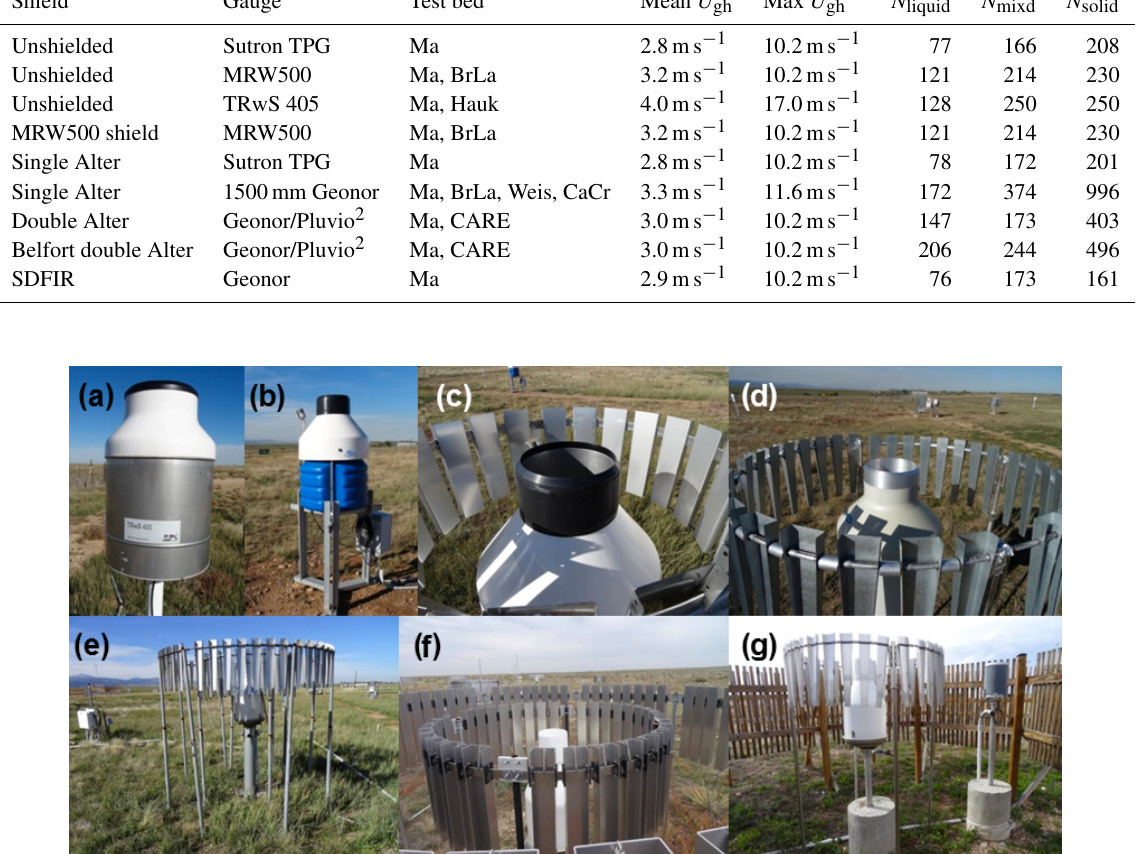
Figure 2. Photos of the (a) TRwS 405, (b) unshielded MRW500, (c) shielded MRW500, (d) single-Alter shielded Sutron, (e) double-Alter shielded Geonor, (f) Belfort double-Alter shielded Geonor, and (g) SDFIR-shielded Geonor at the Marshall, CO, US test